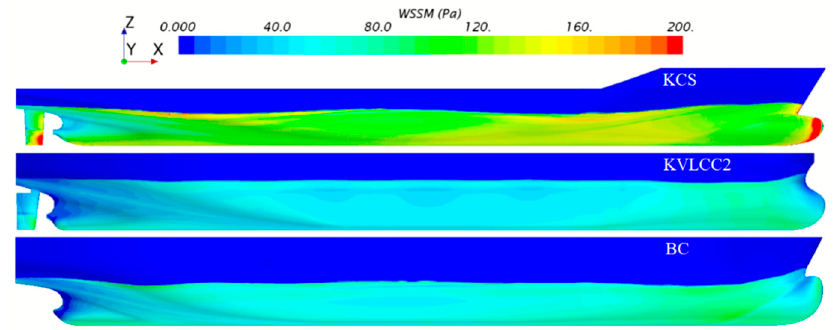
τ distributions for smooth surface condition along the KCS ( upper ), Figure 14. The obtained Figure 14. The obtained τ w distributions for smooth surface condition along the KCS ( upper ), KVLCC2 w ( middle ) and BC ( lower ) KVLCC2 ( middle ) and BC ( lower ) hull.